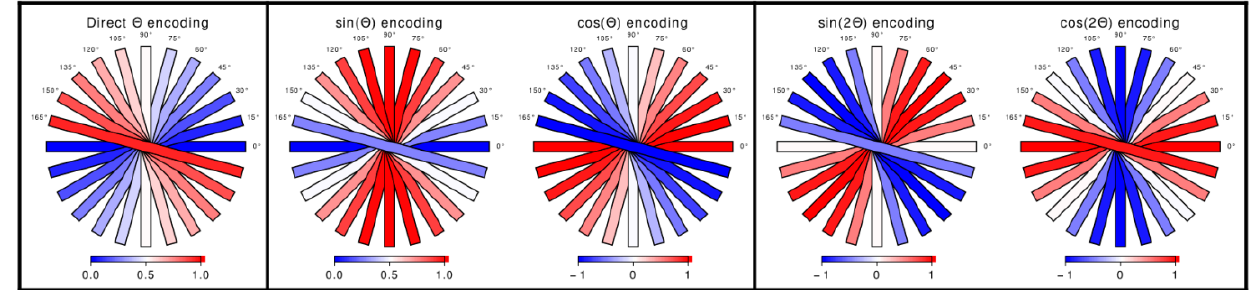
Figure 2. Undirected oriented objects orientation encoding strategies. The object rectangle color represents the orientation encoding